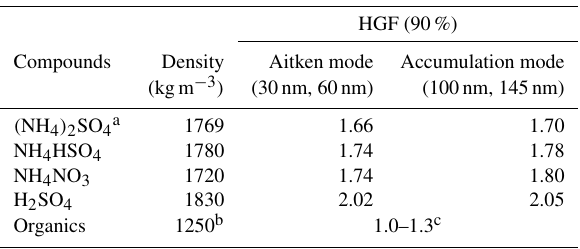
Table 1. Hygroscopic growth factors of all compounds and their individual density used in the ZSR calculation.